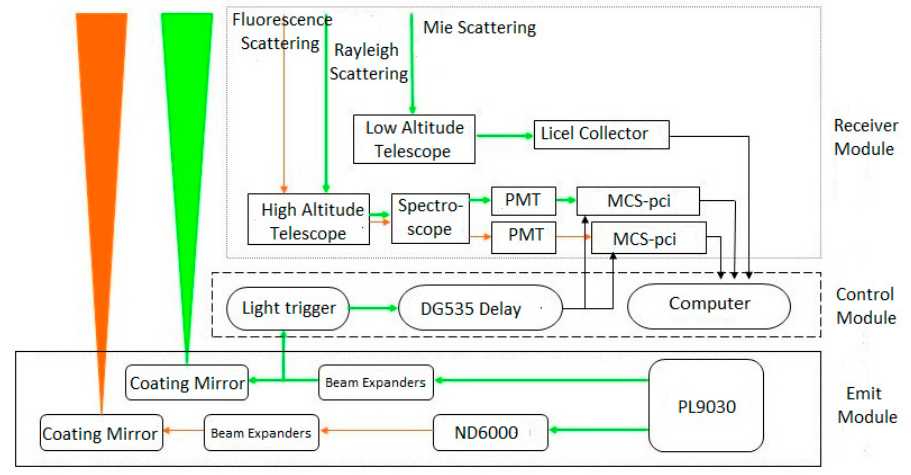
Figure 1. Schematic of our lidar system in Beijing.